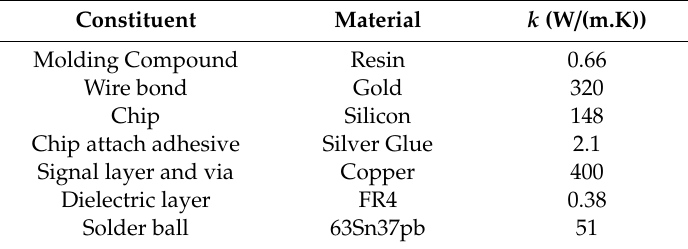
Table 1. Reference material properties. Figure 2. BGA208‘s laminate description.